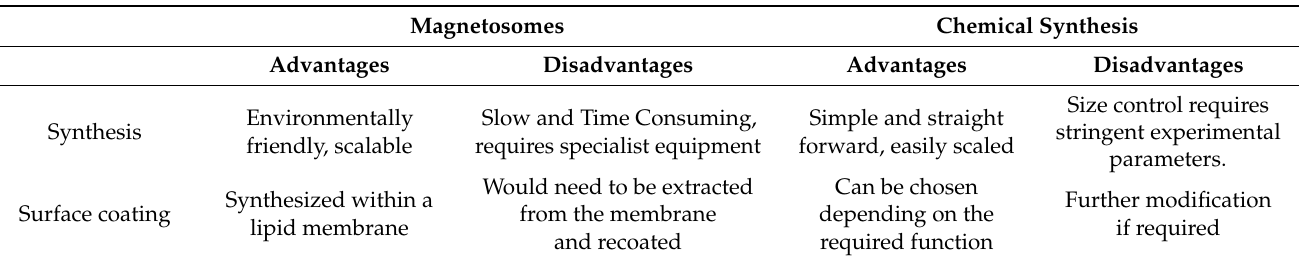
Table 1. Advantages and disadvantages of both naturally occurring magnetosomes and chemically synthesized magnetic nanoparticles